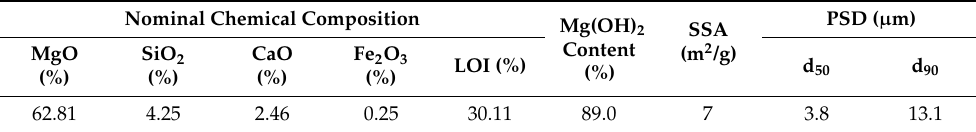
Table 1. The main physicochemical characteristics of used slurry